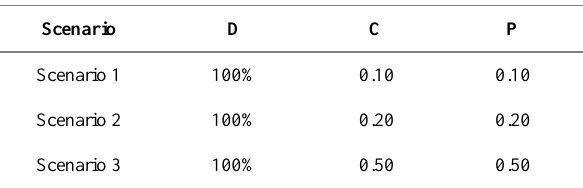
Table 2. Considered